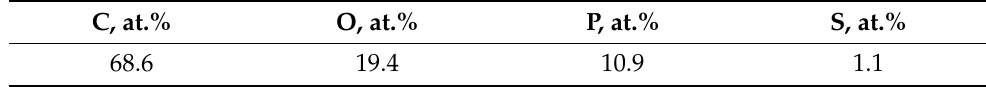
Table 1. Elemental composition of the GPS surface. C, at.% O, at.% P, at.% S, at.%